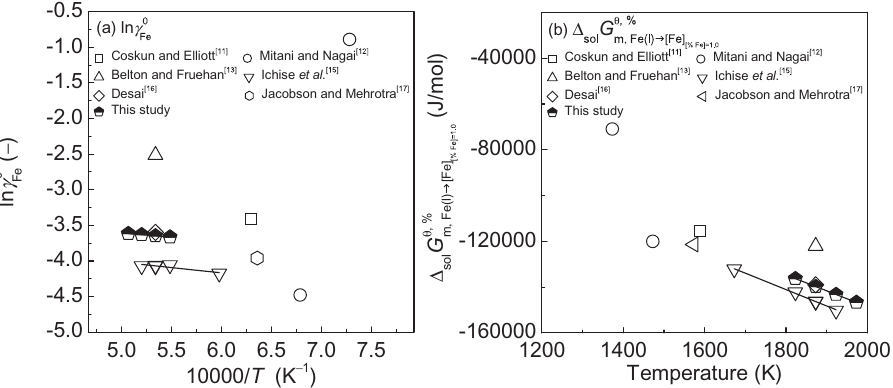
of Fe by various researchers with obtained ones by developed AMCT – N i Fe by various researchers with m,Fe ð l Þ!½ Fe (cid:2) ½ %Fe (cid:2) =1.0